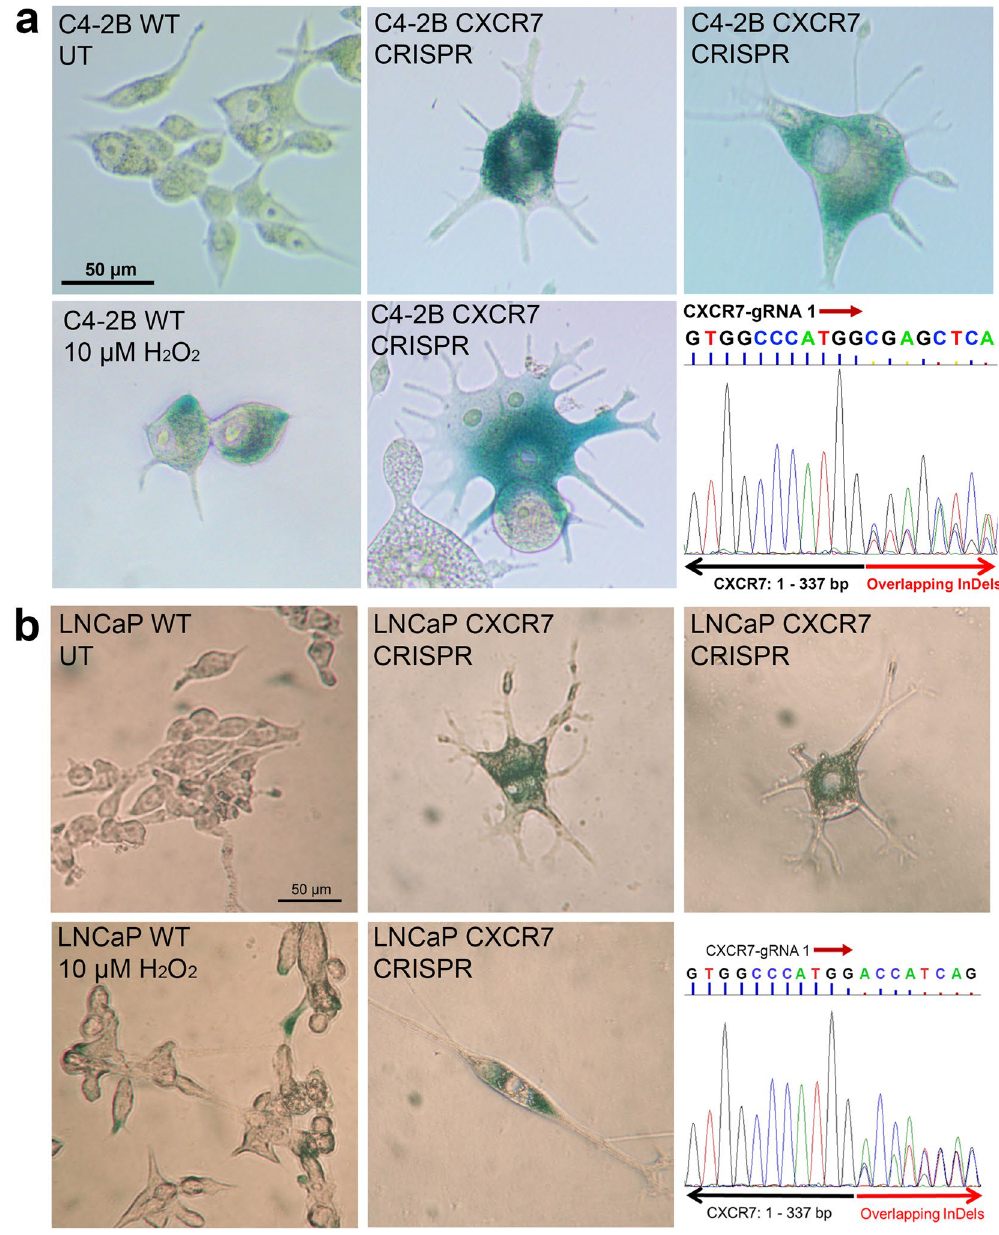
Figure 5. CRISPR-Cas9-mediated frameshift mutations of CXCR7 resulted in the onset of cellular senescence. ( a ) X-gal assay for SA- β -galactosidase (SA-gal) activity in C4-2B CXCR7 frameshift mutant cells. Positive SA- gal expression is indicated by dark blue coloration to the cells. Upper-left panel: C4-2B cells with wild-type (WT) CXCR7 expression untreated (UT) (negative control), Lower-left panel: WT C4-2B cells treated with 10 µ M H 2 O 2 (positive control). Upper-middle, lower middle, and upper-right panels: representative images in CXCR7-CRISPR-mutated cells. Lower-right panel: Sanger sequencing chromatogram of the CXCR7-gRNA target site illustrating overlapping unique CXCR7 InDel mutations. ( b ) X-gal assay in LNCaP CXCR7 frameshift mutant cells and controls (UT or H 2 O 2